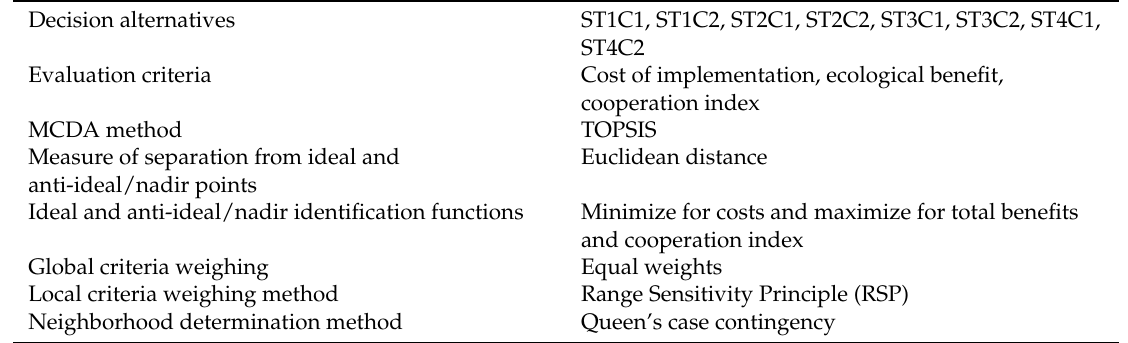
Table 1. Summary of the framework according to which we apply MCDA in our